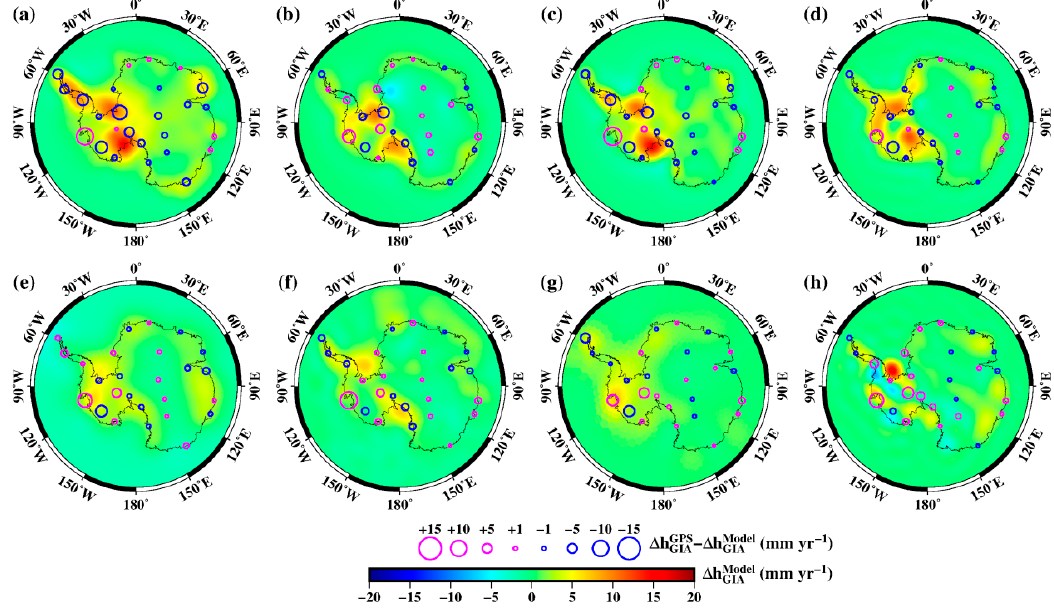
Figure 5. Antarctic GIA uplift rates estimated from the following solutions: ( a ) RF3L20; ( b ) W12a; ( c ) A13; ( d ) ICE6G; ( e ) G14; ( f ) G16; ( g ) RATES; ( h ) REGINA, and their discrepancies of GIA uplift rates with GPS observations computed at each station. Table 4. The weighted mean (WM) and WRMS residuals, in mm/yr, between the estimated and observed GIA uplift rates at each GPS location. Note that the elastic-corrected GPS uplift rates proposed by Martín-Español et al. [62] and the way of WRMS calculation here is slightly different from Equation (10) (see Equation (2) in Martín-Español et al. [62]). WA (7) EA (10) AP (3) All (20) GIA GIA WM WRMS